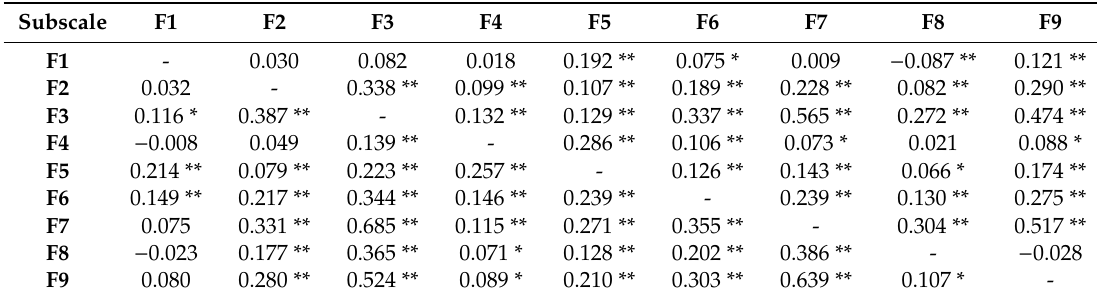
Table 7. Covariances between latent